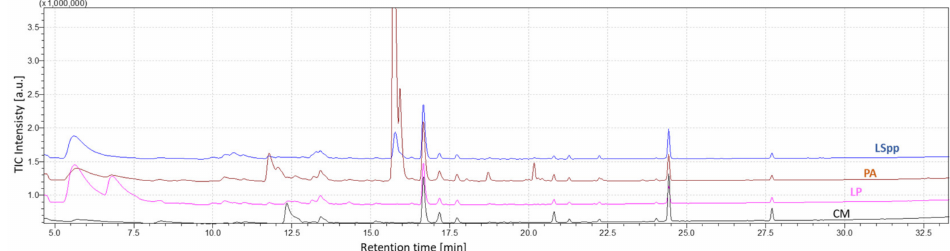
Figure 6. Comparison of chromatograms obtained from analysis of culture headspace of Legionella species (blue line), Pseudomonas aeruginosa (red line), Legionella pneumophila (pink line) and not- inoculated BYE α broth (CM-black line). Samples were inoculated for 7 days before the